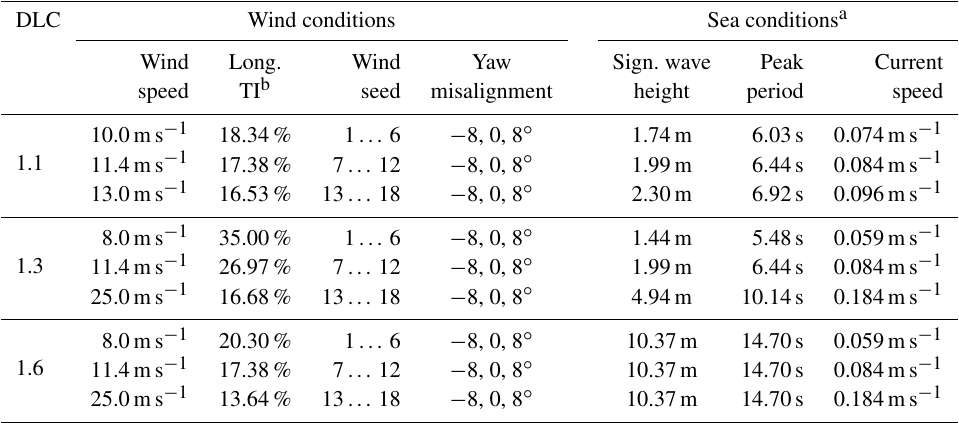
Table 4. System parameters for preprocessing simulations of selected DLCs (Leimeister et al., 2020b). DLC Wind conditions Sea conditions a Wind Long.